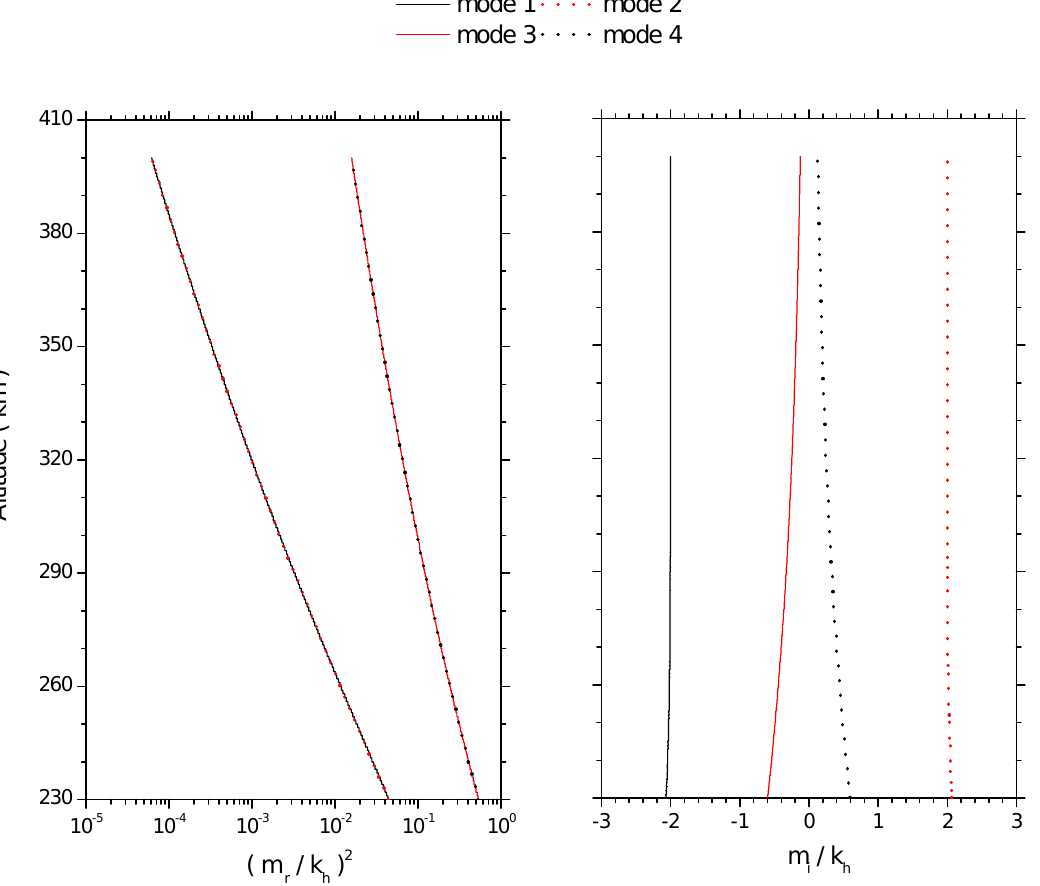
Figure 9. Four pseudo-adiabatic wave modes above a 230-km